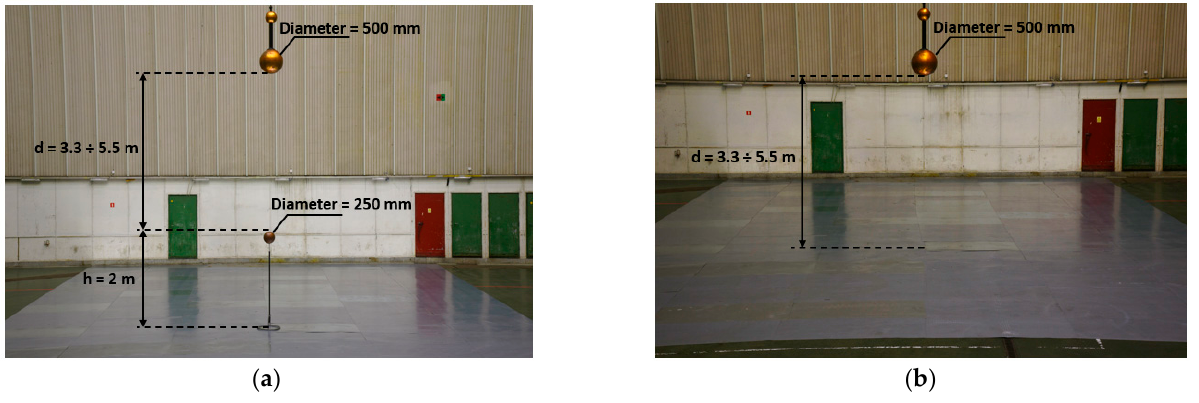
Figure 5. Spark gaps: ( a ) sphere-sphere (500 mm copper ball at high voltage, 250 mm copper ball grounded); ( b ) shere-plane (500 mm copper ball at high voltage, steel sheets measuring 17 m by 11 m grounded). The high-voltage electrode hungs on the transportation crane via an insulating string made of composite long rod insulators, the plane electrode is connected to the laboratory grounding system via a copper tape, the 250 mm grounded ball is mounted on the top of the steel pipe with a diameter of 30 mm.